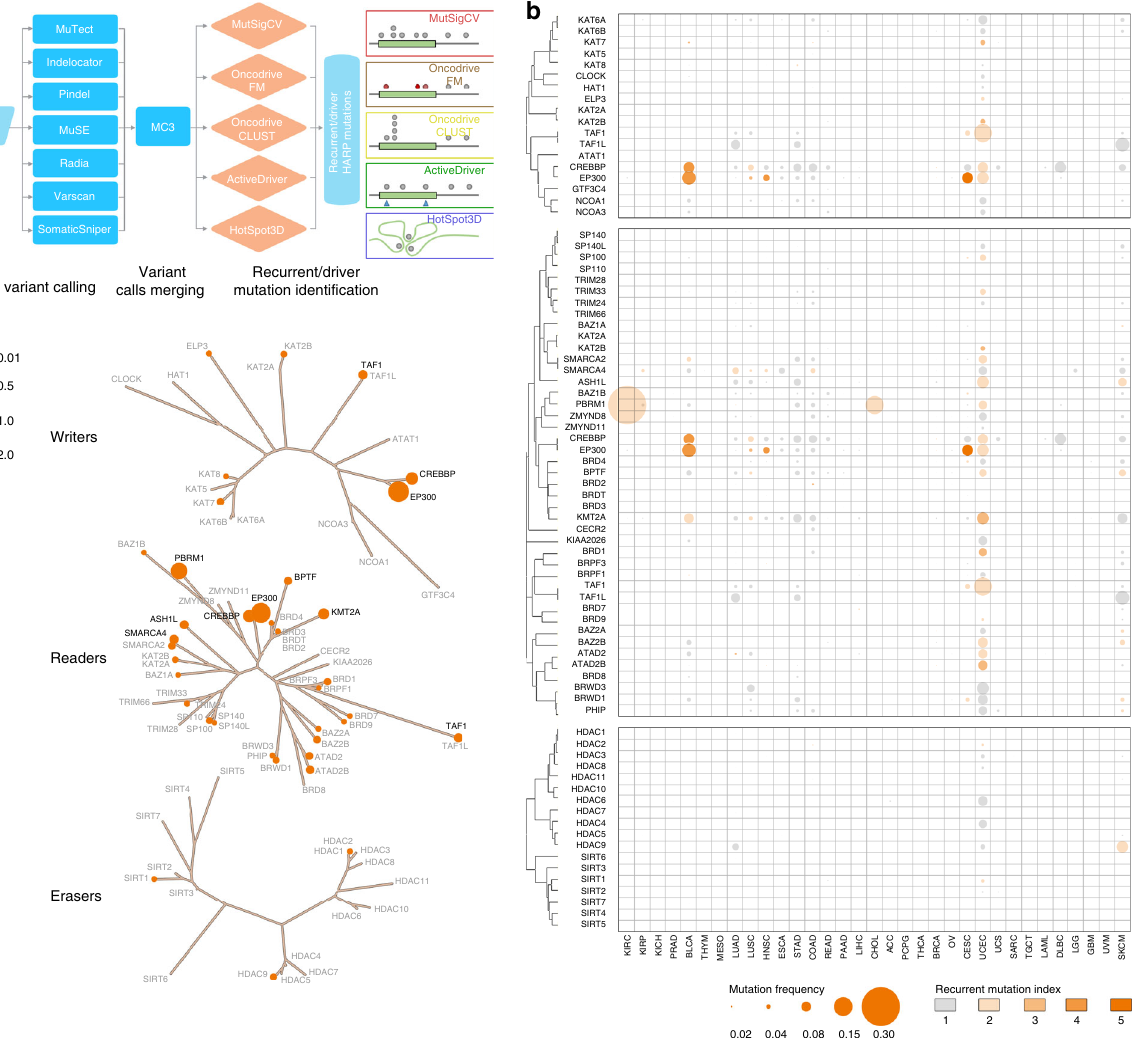
Fig. 4 Somatic mutations of HAMPs across cancers. a The work fl ow of somatic mutation analysis. Seven algorithms were used for variant calling and fi ve approaches were used for recurrent mutation identi fi cation. b The bubble plot shows the mutation frequencies and mutation indexes of the putative cancer-causing HAMPs driven by somatic mutations in each cancer type. The size of the bubble: mutation frequency; intensity of color: mutation index. The phylogenetic trees were generated by multiple sequence alignments of the full-length sequences of the proteins. c Summary of the overall M-scores of the putative cancer-causing HAMPs driven by somatic mutations, which were identi fi ed in at least one cancer type. The size of the bubble: the overall M-score. The HAMPs coding in black and gray indicate a gene with an overall M-score ≥ 0.4 and < 0.4, respectively. The phylogenetic trees were generated by multiple sequence alignments of the full-length sequences of the